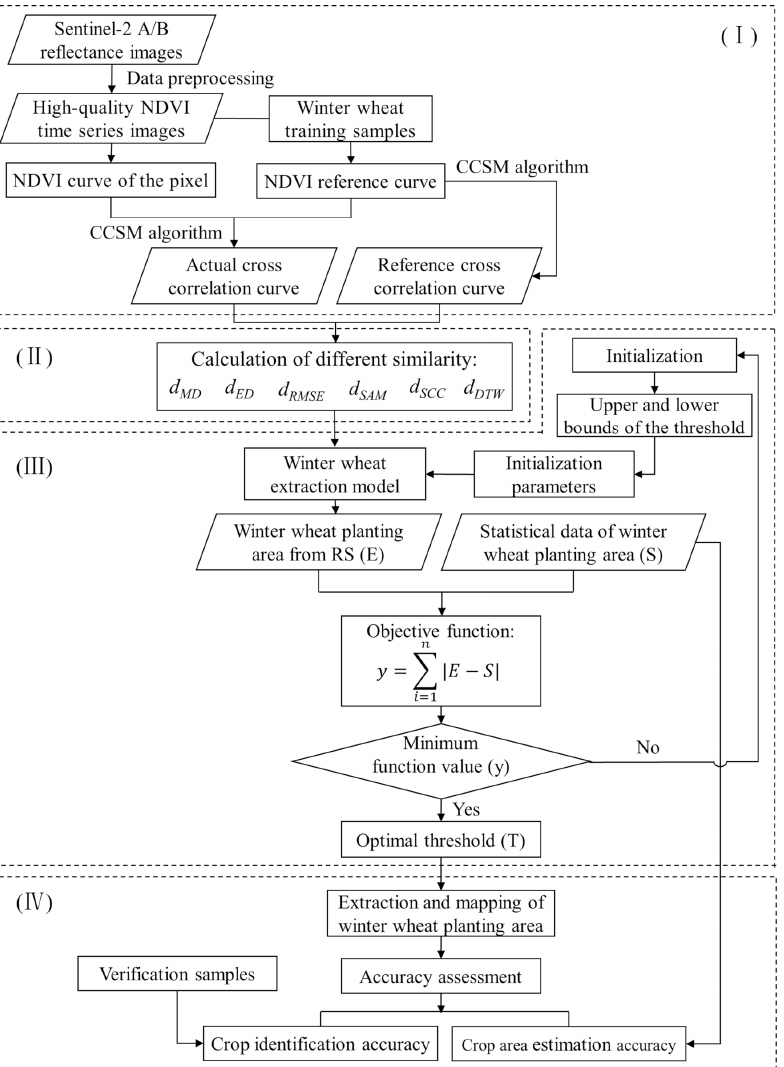
Figure 3. Flowchart for extracting and mapping winter wheat. (Note: The software ENVI and MATLAB were used in step I; steps II and III were mainly carried out in MATLAB; and in step IV, ENVI, and ArcMap were mainly used.).